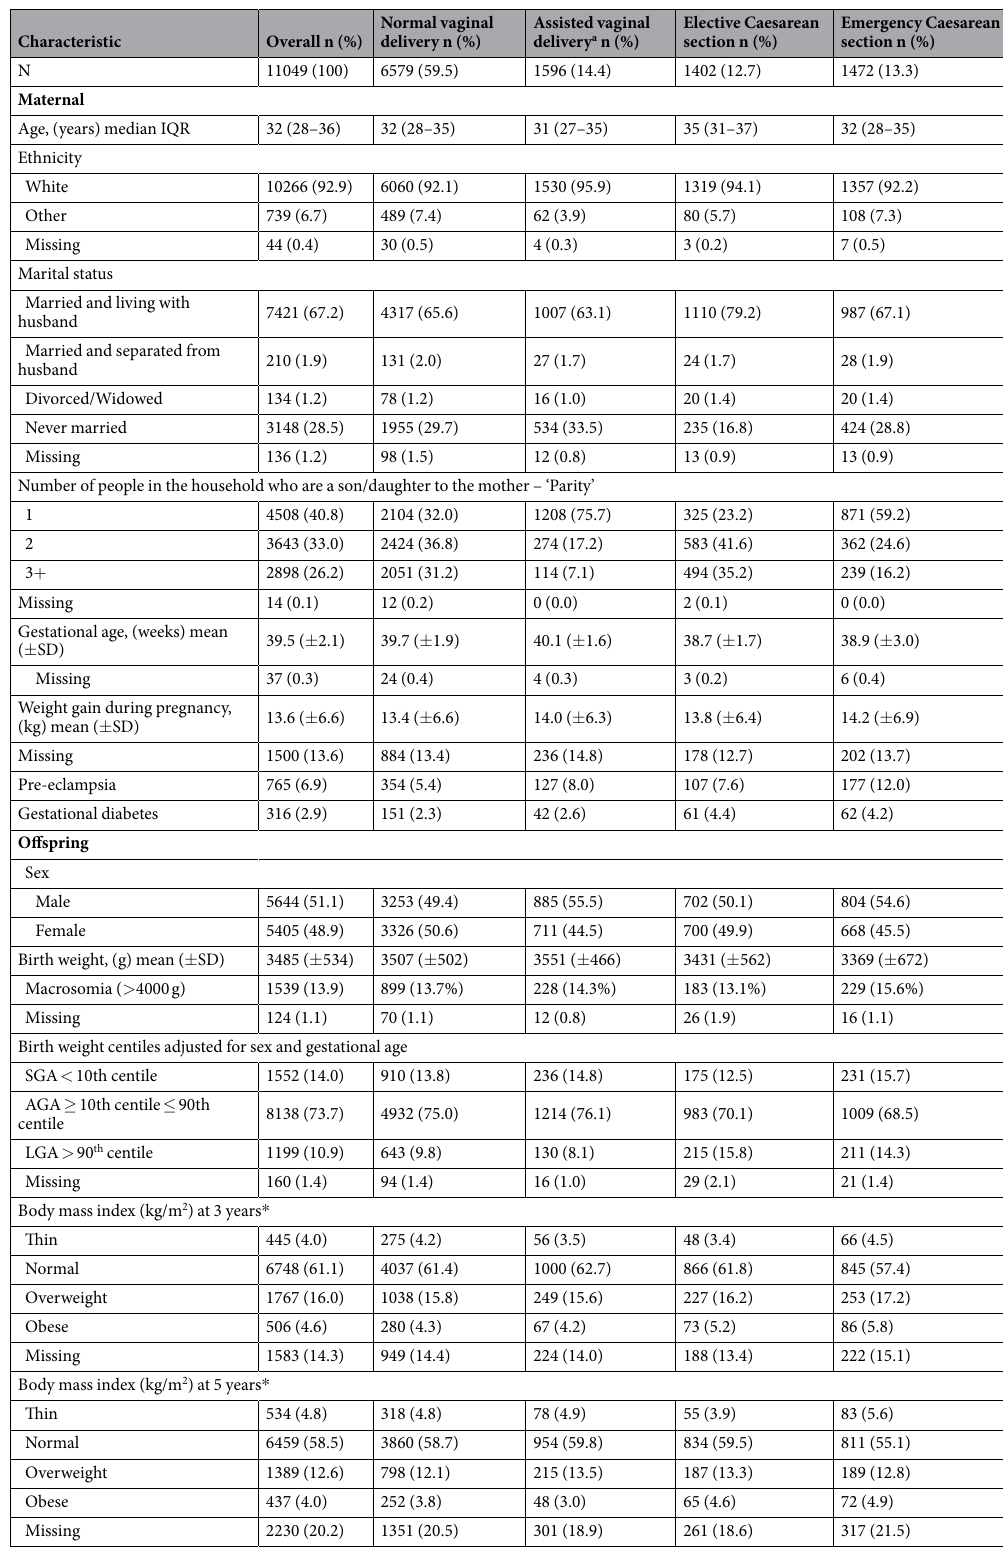
Table 2. Characteristics of the study population. SD (Standard deviation), IQR (Interquartile range), SGA (Small for gestational age), AGA (Appropriate for gestational age), LGA (Large for gestational age). a Vacuum or forceps. * International Obesity Task Force age and sex-specific cut-offs. Educational level not shown because of up to 14 overlapping categories that were challenging to recode into coherent mutually exclusive groups, missing data 10